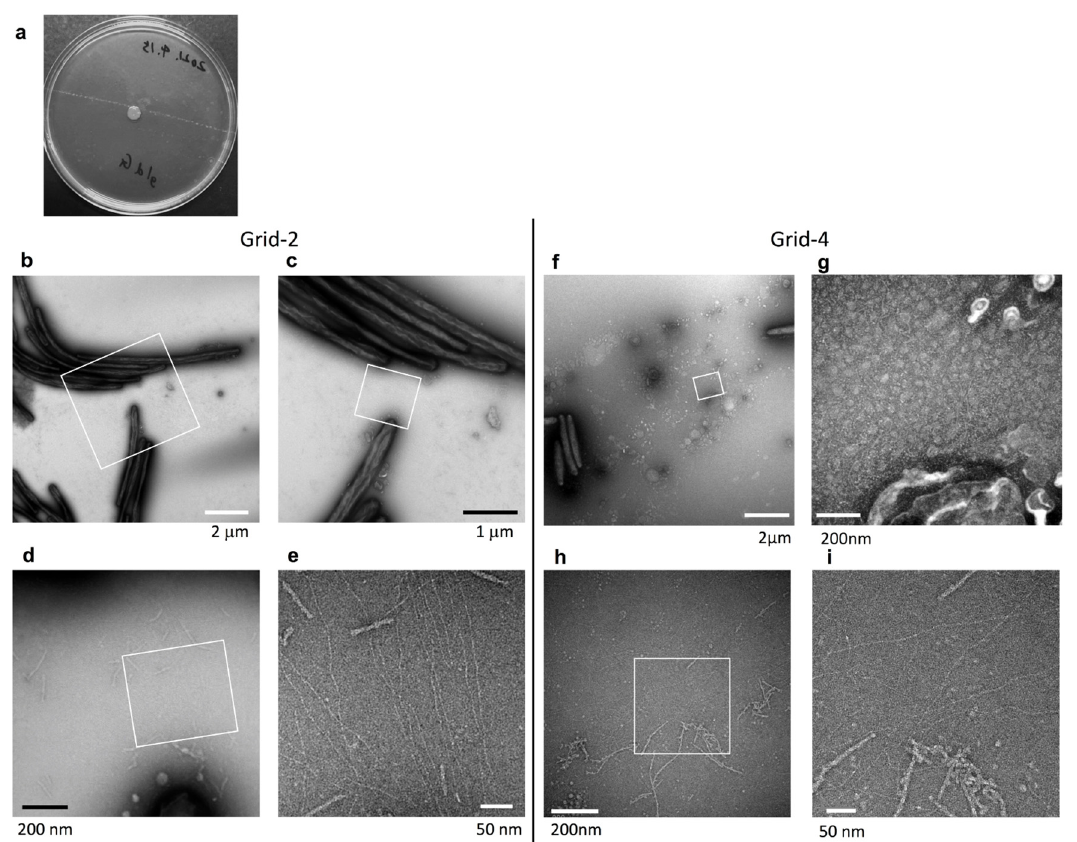
Figure 7. Colony surface of nonspreading gldG mutant colonies imaged using the grid stamp method. ( a ) Colony spreading of gldG mutant on 1% A-PY2 as in Figure 6. ( b – e ) Colony surfaces were sampled using the grid stamp method at the edge of the colony body (Grid position 2). ( b ) Low magnification grid stamp image recorded at the edge of a typical nonspreading gldG mutant colony. ( c ) Higher magnification image of the white square in the preceding panel. ( d ) Higher magnification image of the square indicated in ( c ). ( e ) Higher magnification image of the square in ( d ). Although the cells made head-to-tail and/or side-to-side contact like cells in the WT and gldK colonies. The space between the cells was occupied not only by thin fibers and small vesicles but also by thick fibers (5–8 nm in diameter) and large vesicles (150–250 nm), which are missing in the images of the gldK colony. ( f – i ) Top surfaces 2 mm inside the edge of the nonspreading gldG mutant colony (Figure 1b, Grid position 4). ( f ) Low magnification image. ( g ) Higher magnification image of the square in ( f ). ( h ) Low magnification image of another area. ( i ) Higher magnification image of the square in ( h ). Almost no cells were imaged, but small vesicles are prominent. ( g – i ) Higher magnification images. The area was occupied by small vesicles and